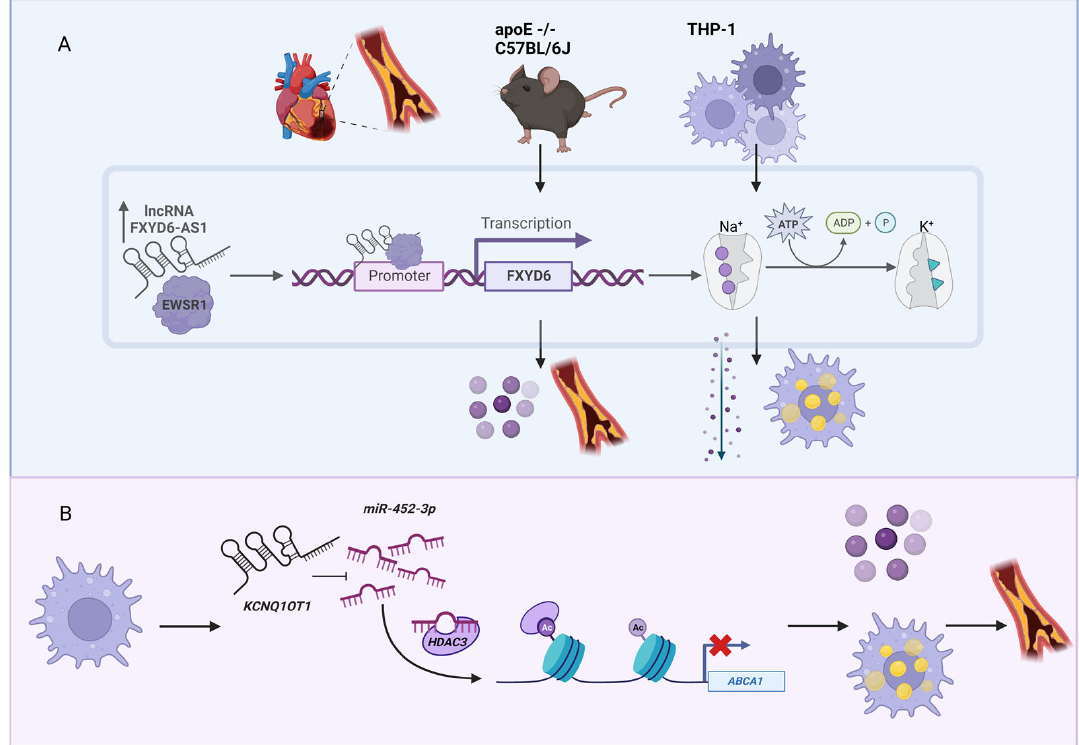
Figure 2. LncRNAs associated with atherosclerosis development. ( A ) The lncRNA FXYD6-AS1 is overexpressed in the patients with atherosclerosis as well as in the apoE deficient mice fed with a Western diet. Together with EWS RNA binding protein 1 (EWSR1), FXYD6-AS1 regulates the expression of the protein-coding gene FXYD6 , which is the main modulator of Na + /K + -ATPase activity. ( B ) The lncRNA KCNQ1OT1 functions as a miRNA sponge. This lncRNA sequesters miR-452-3p , which binds to histone deacetylase 3 (HDAC3) and thus inhibits the expression of ATP binding cassette subfamily A member 1 ( ABCA1 ). Phenotypically, this cascade results in lipid accumulation and proinflammatory cytokine release in macrophages and accelerates the atherosclerotic development. Figure created withBioRender.com (accessed on 9 December 2022).